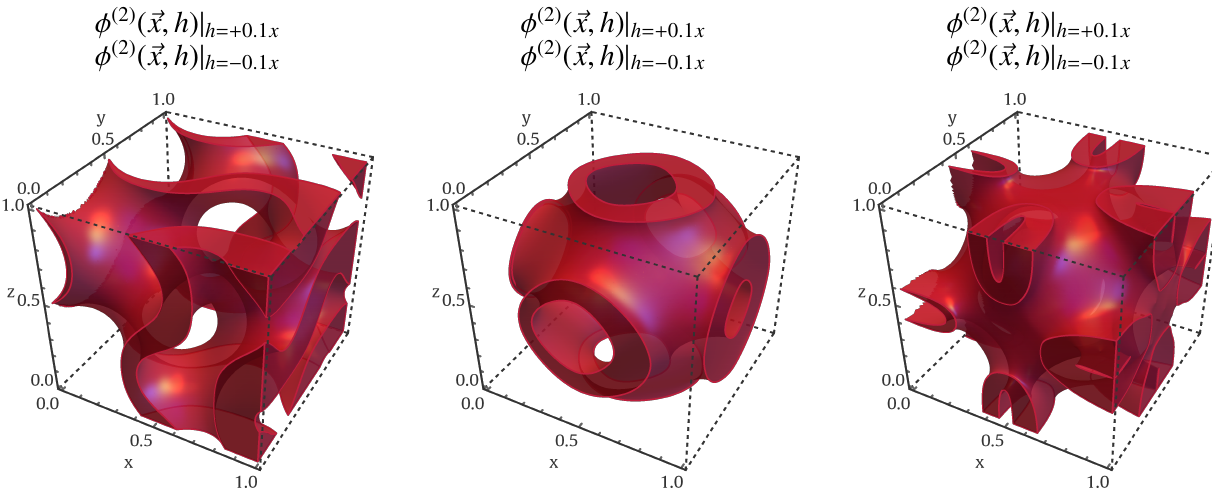
Figure 9. Infill volume enclosed between two offset contours from the original interface F ( (cid:126) x ) = 0 of the Gyroid, Schwarz P, and Neovius, respectively. For a unit cell, the offset distance linearly increases from 0 up to 0.1 in the x direction. In the above figures, the method used to obtain the implicit representation for each of the offset interfaces is the second-order